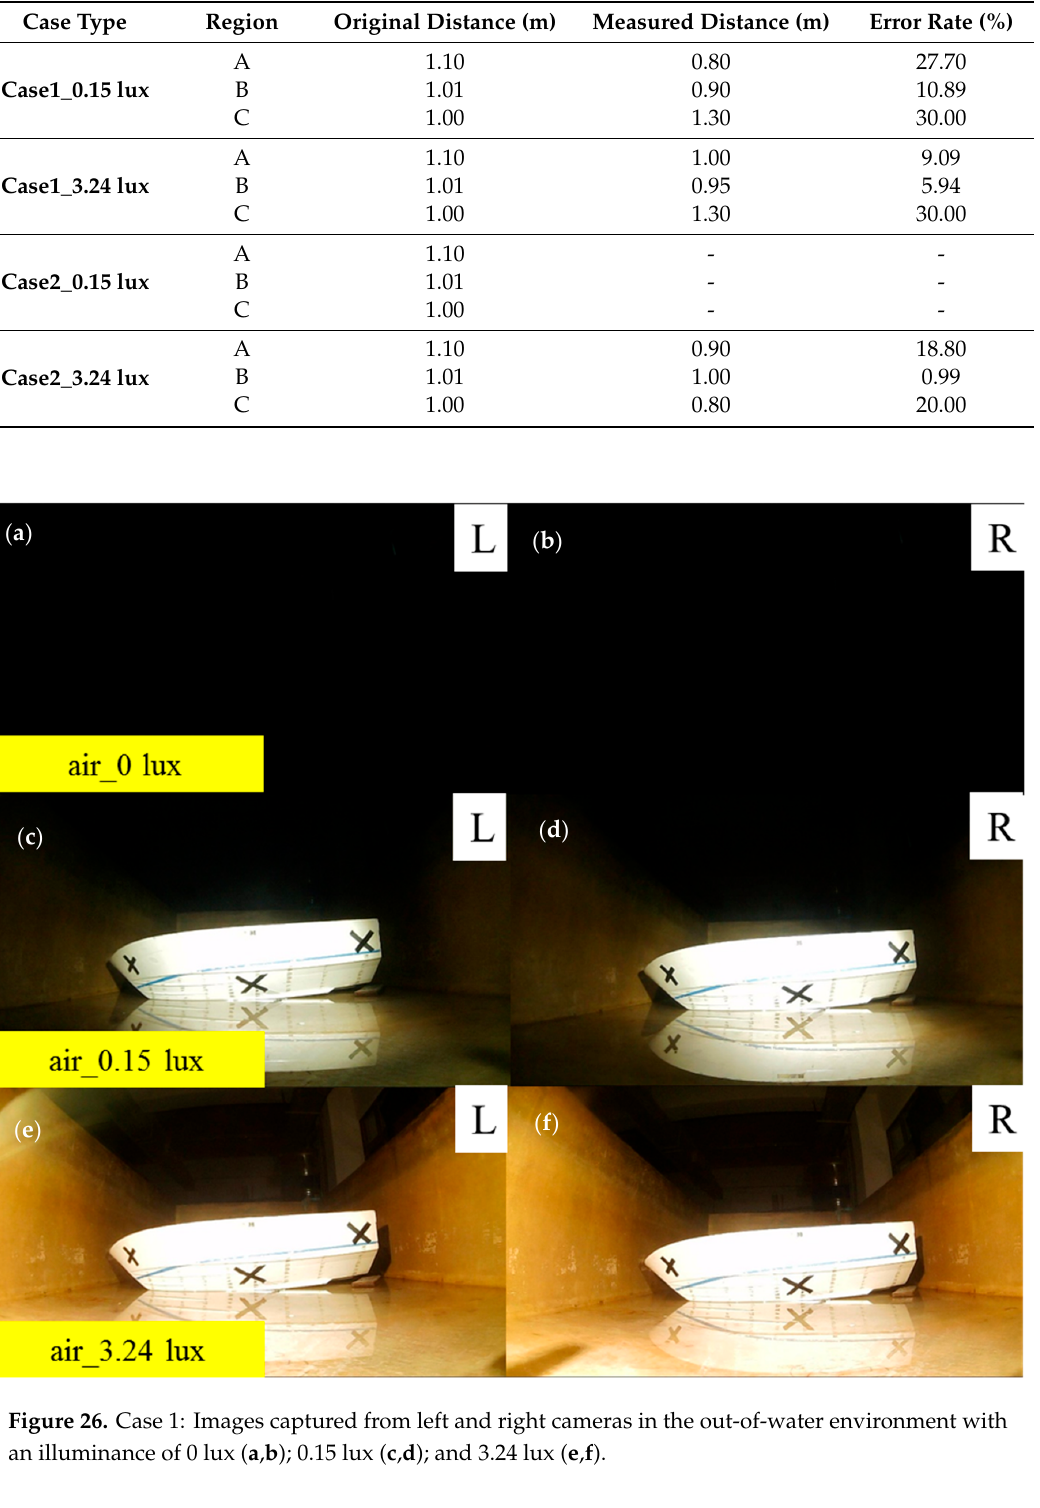
Table 12. Analysis results obtained from stereoscopic measurement in the underwater environment with turbidity 1.1 NTU (error rate (%) = ( | original distance − obtained distance | ) / (original distance) × 100%).